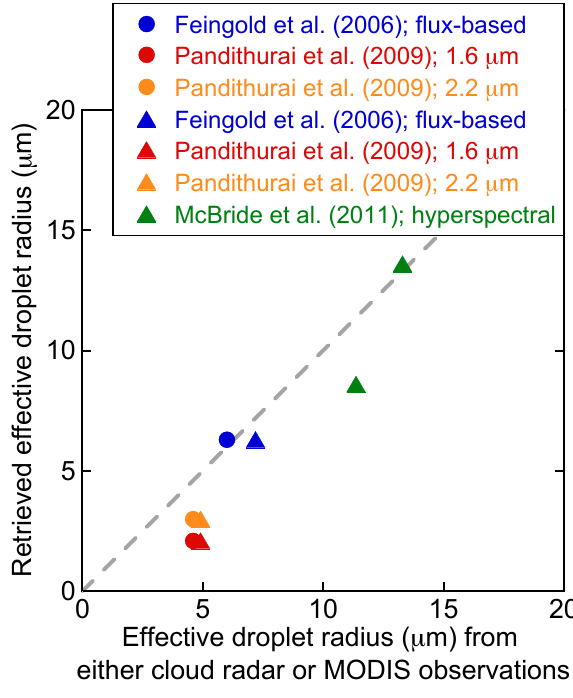
Fig. 1. Scatter plot of effective droplet radii retrieved from ground-based transmittances versus those from either ground-based cloud radar (dot) or MODIS (triangle) observations. Cloud effective radii from Feingold et al. (2006) were retrieved from combined flux and microwave measurements, and represented 3-h statistics for stratus clouds at the ARM Oklahoma site in 2003. Retrievals from Pandithurai et al. (2009) were based on multichannel zenith radiance and represented 3-day statistics for low-level, overcast ice-free water clouds at Okinawa Island, Japan in 2008; the use of liquid water-absorbing wavelength (i.e., 1.6 or 2.2 µm) slightly changed the retrieved cloud effective radii. Similarly, retrievals from McBride et al. (2011) were based on hyperspectral zenith radiances, and compared to two MODIS overpasses for overcast water clouds at the ARM Oklahoma site in 2007.